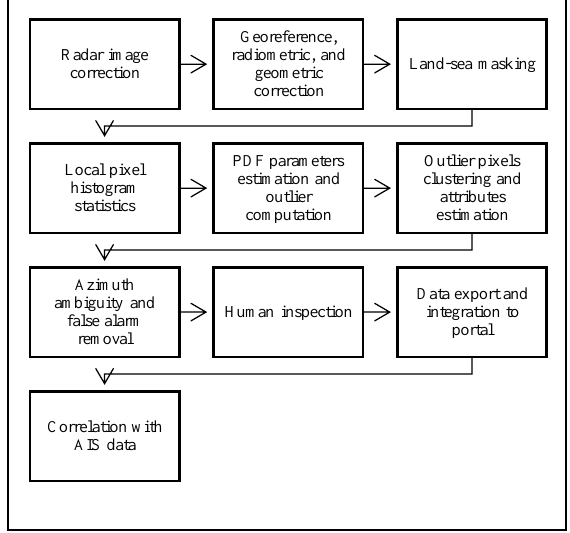
Figure 3 . Generated workflow for the maritime monitoring and surveillance system and automatic ship detection algorithm. Level 1 images are georeferenced with GPS data with calibrated backscatter values. To narrow down the search area, sea masks are applied using the Philippines’ Exclusive Economic Zone (EEZ) with a coastline buffer of 3 kilometers to address subtle georeferencing errors. Constant false alarm rate detectors aim to identify pixels that are potential outliers with respect to its neighbors (Serco, 2018). The algorithm assumes a Gaussian pixel value exceeds the adaptive threshold set by the false alarm rate. Adjacent outlier pixels are clustered and their sizes are estimated. Pixel groups that fit the target size criteria are regarded as ships and others are discarded since they are false alarms.